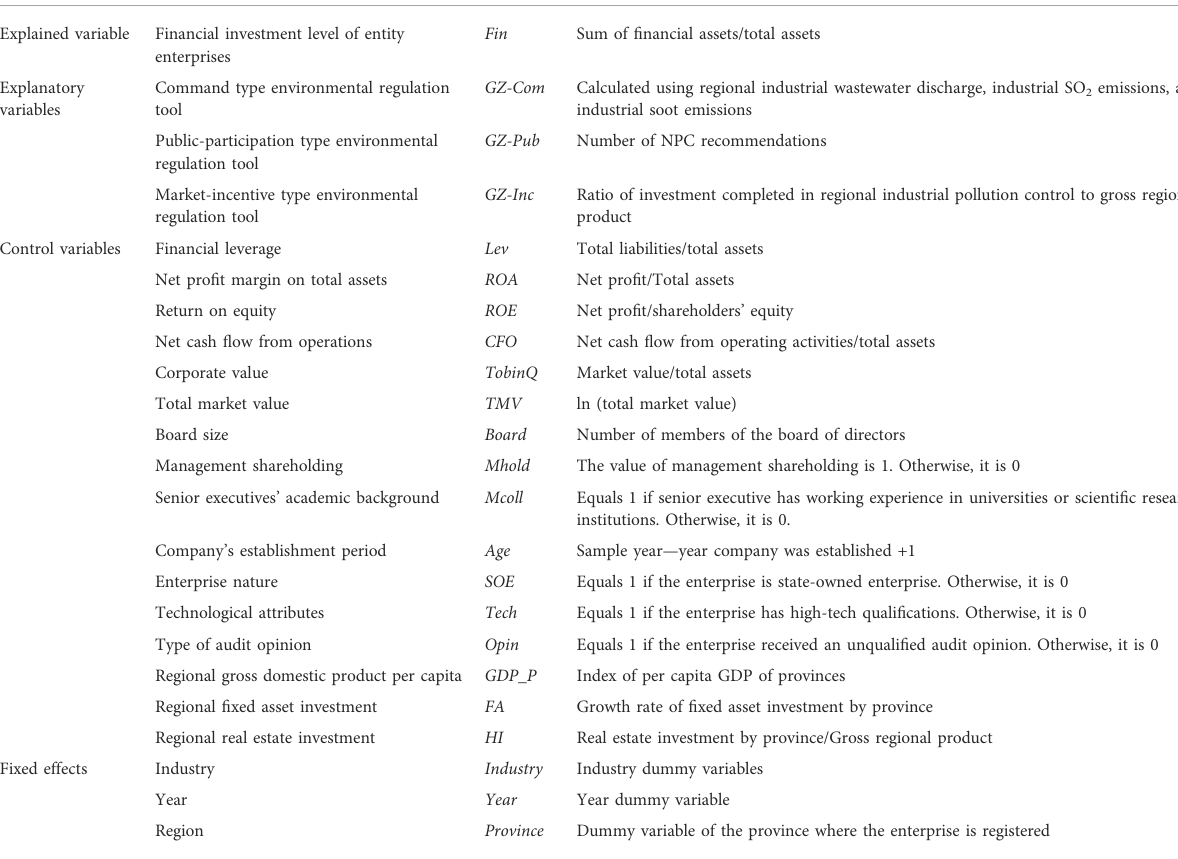
TABLE 1 Variable de fi